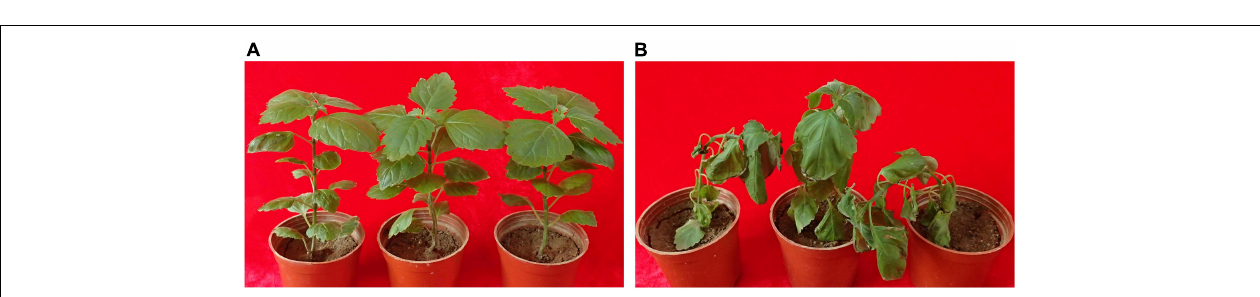
FIGURE 2 | The plant phenotypes of pathogenicity test at 7 days post-inoculation. (A) Plants mock-inoculated with sterile water; (B) Plants inoculated with strain Pa82.